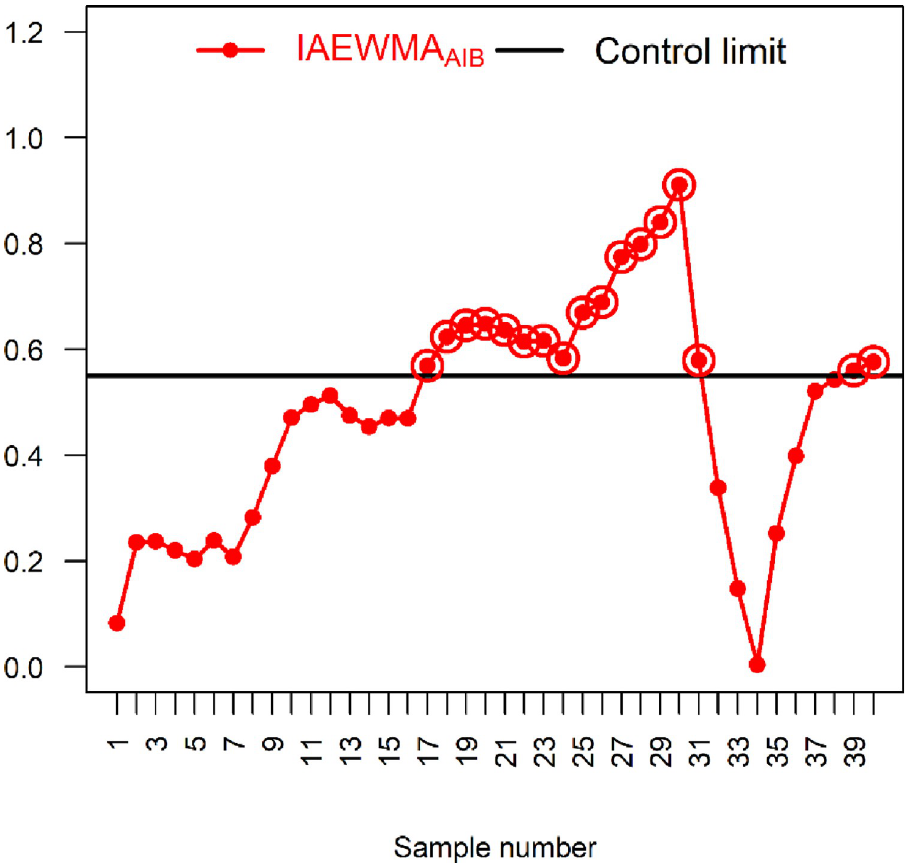
Fig 5. Proposed IAEWMA AIB control chart with real-life data of glass manufacturing industry using ρ = 0.905, λ 1 = 0.2, λ 2 = 0.1, h ¼ 0 : 5506 and ARL 0 = 500. IAEWMA AIB